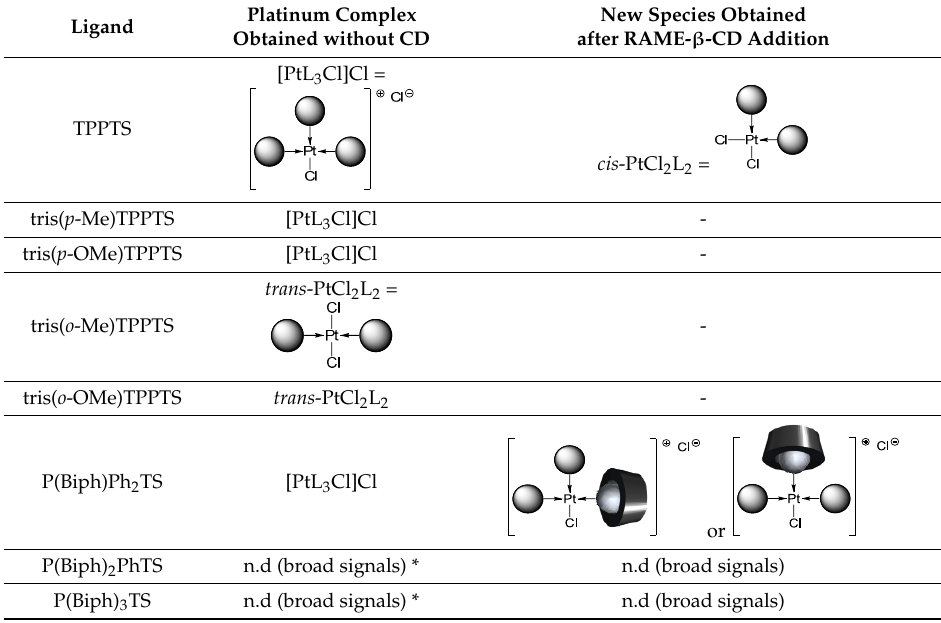
Table 2. Organometallic species formed by adding 3 equiv. of ligand to a K 2 PtCl 4 aqueous solution (10 mM) and after RAME- β -CD addition (1 to 12 equiv. toward platinum).